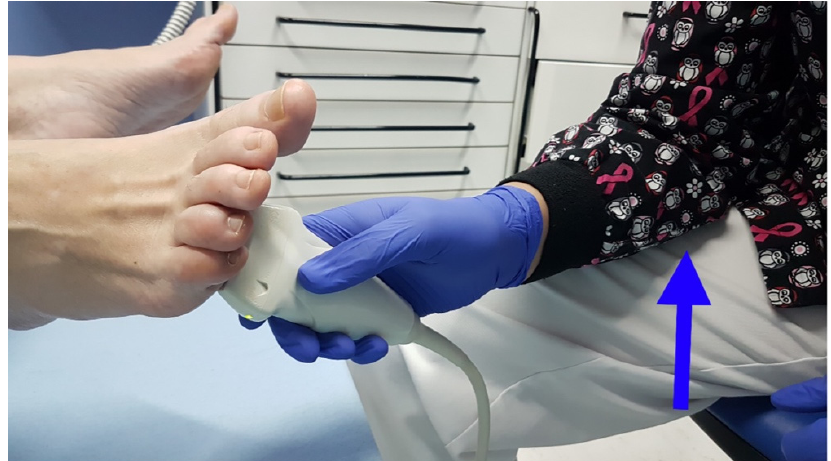
Figure 1. The evaluator will be seated, resting their arm on their leg (blue arrow) for stability, and will not touch the patient’s foot.